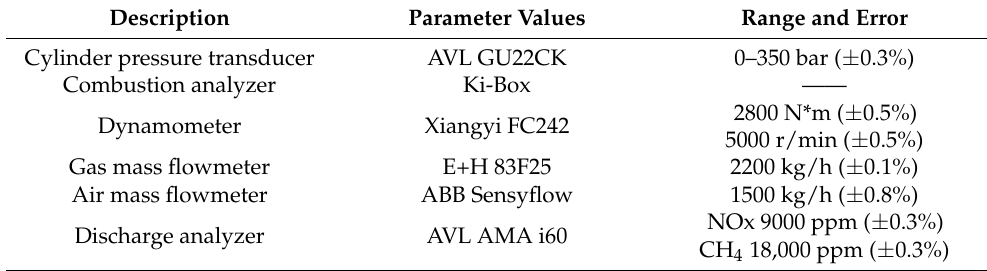
Table 2. Main equipment information.